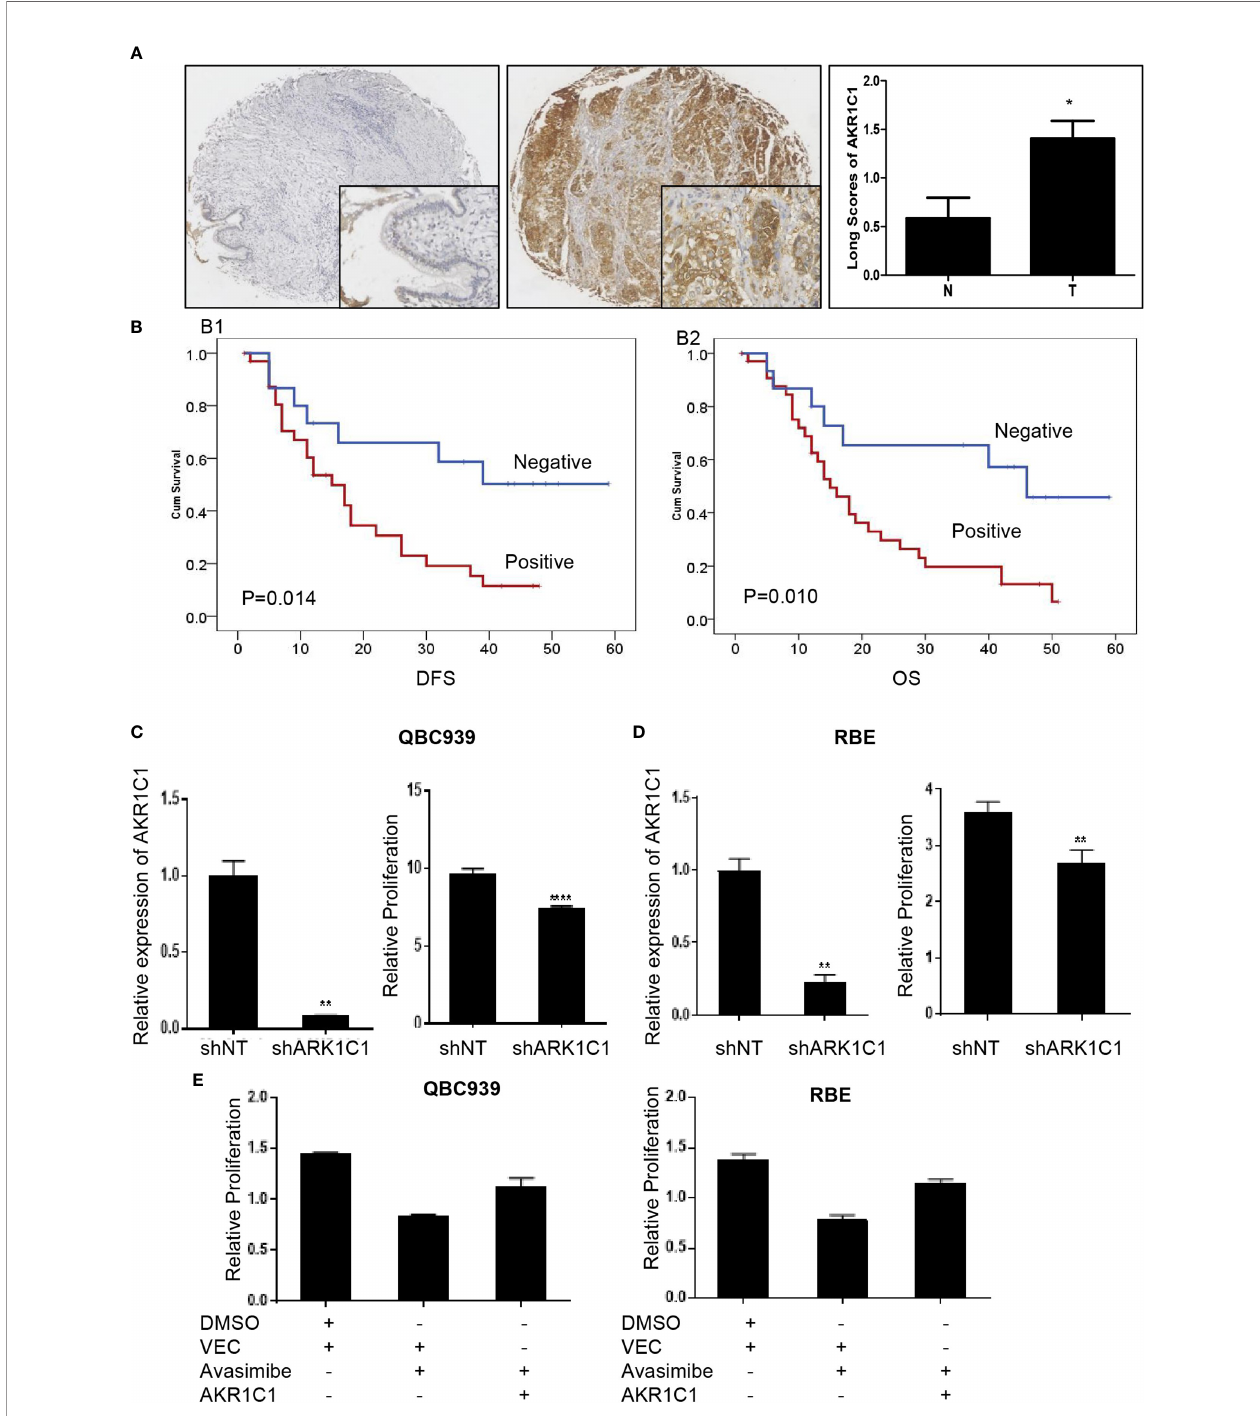
FIGURE 3 | The oncogenic role of AKR1C1 in cholangiocarcinoma. (A) Representative images of negative staining of AKR1C1 in noncancerous tissues (N) and high expression of AKR1C1 in CCA (T). IHC,×200 for small pictures and×40 for large pictures. *P < 0.05. (B) Patients with AKR1C1 expression had a shorter time to recurrence (B1) and a worse overall survival (B2) than those without AKR1C1 expression. (C, D) QBC939 (C) and RBE (D) cells were transfected with AKR1C1- shRNA for 48 hours and the level of AKR1C1 mRNA was detected by RT-PCR. CCK8 assay was used to measure the cell viability of both cell lines. **P < 0.01, ****P < 0.0001. (E) QBC939 and RBE cells were treated with avasimibe with or without exogenous AKR1C1 plasmid for 48 hours and CCK8 was used to detect the changes of cell viability. IHC, immunohistochemistry; CCK8, Cell Counting Kit-8; Vec,